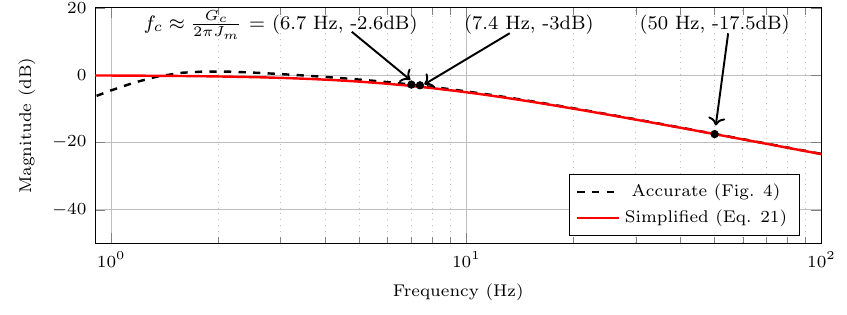
Figure 8. Frequency bode plot of the SS-WTS, where the bode plot as determined by Mat- lab/SIMULINK (Accurate) is given by the dashed line and the simplified transfer function of (21) is given by the solid